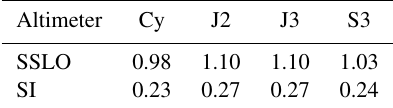
Table 1. Symmetric best-fit slope (SSLO) and scatter index (SI) of the wave model data vs. the altimeter data. Cy refers to Cryosat, J2 refers to Jason-2, J3 refers to Jason-3, and S3 refers to Sentinel-3. Altimeter Cy J2